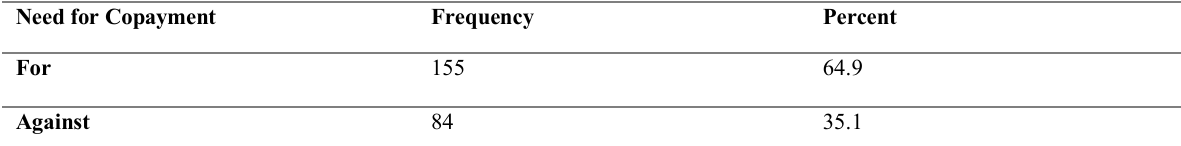
Table 1: Copayment charge